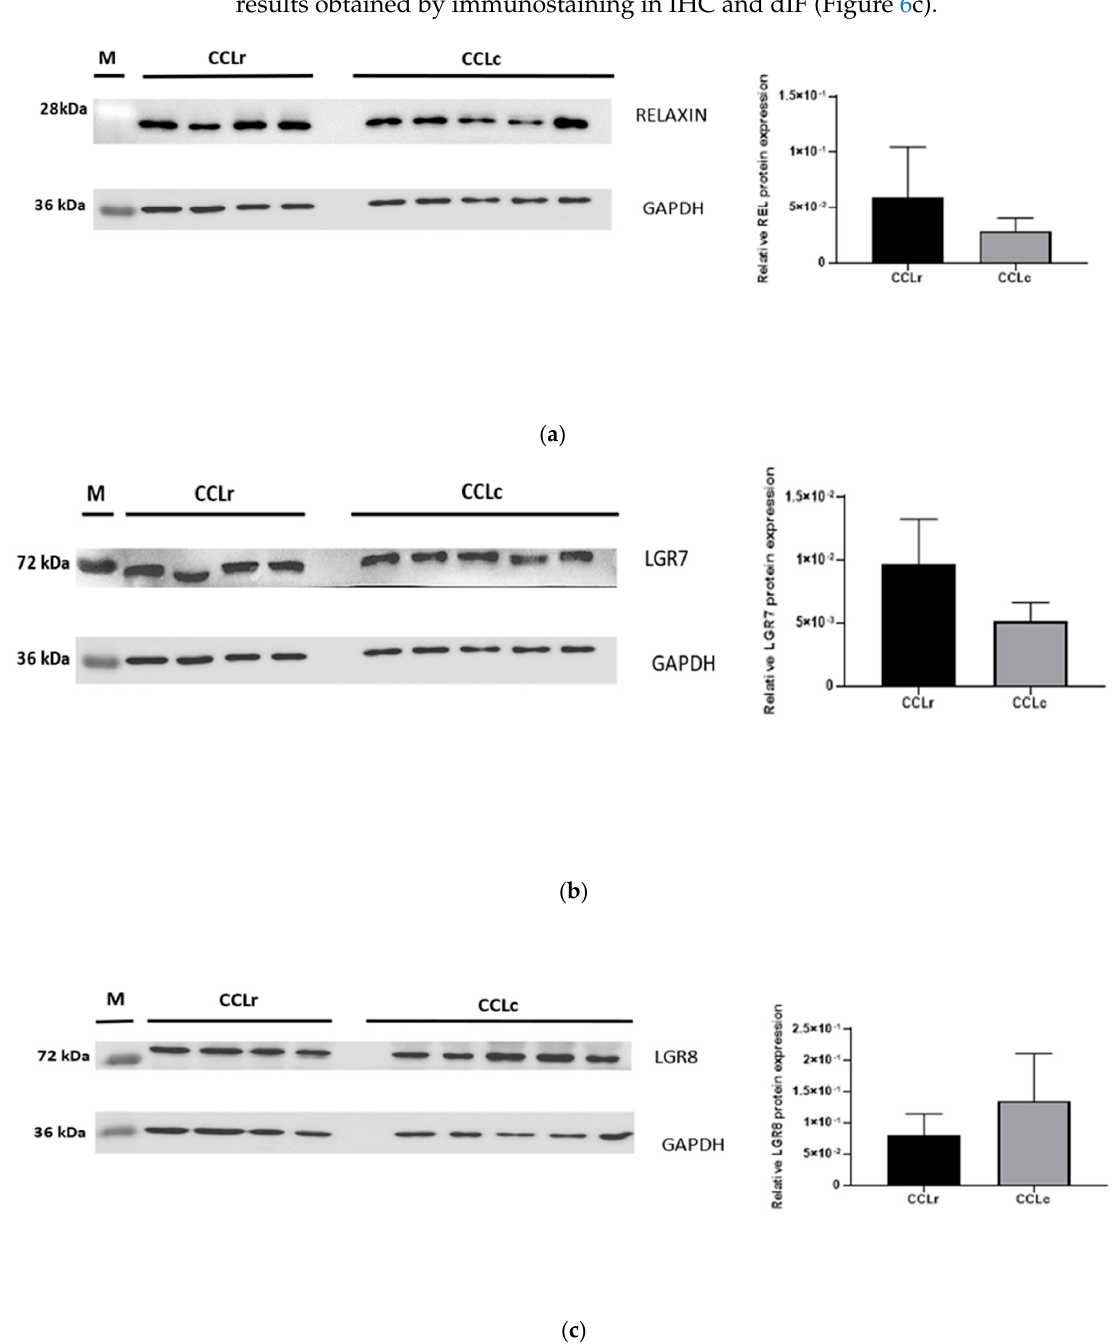
Figure 6. Western blot analysis of relaxin ( a ), LGR7 ( b ), and LGR8 ( c ) protein expression in four CCLr tissue samples and in five CCLc tissues. The bar graphics show the mean ± SEM of relative relaxin, LGR7, and LGR8 protein expression in the CCLr and CCLc samples. Plots show